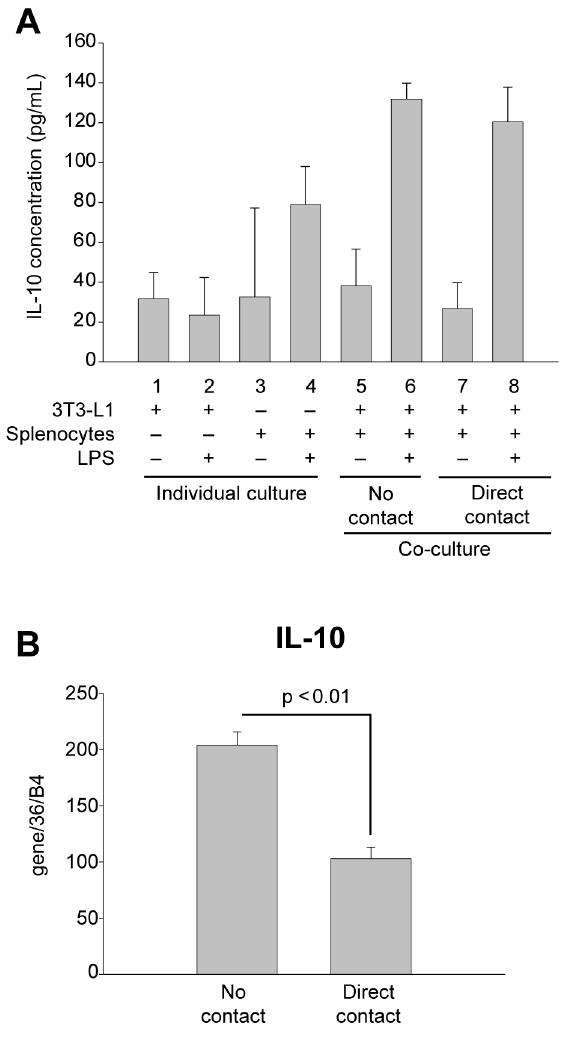
Figure 5. Effects of paracrine factors and cell contact on IL-10 secretion and expression. (A) Differentiated 3T3-L1 adipocytes or wild type murine splenocytes were cultured alone (columns 1 and 2 or 3 and 4, respectively) or together with either no contact (columns 5 and 6) or direct contact (columns 7 and 8). Cells were incubated in the absence (-) (columns 1, 3, 5 and 7) or presence ( + ) (columns 2, 4, 6 and 8) of LPS (1 m g/mL) for 24 h as indicated. Interleukin-10 (IL-10) in culture media was quantified by capture ELISA. (B) Differentiated